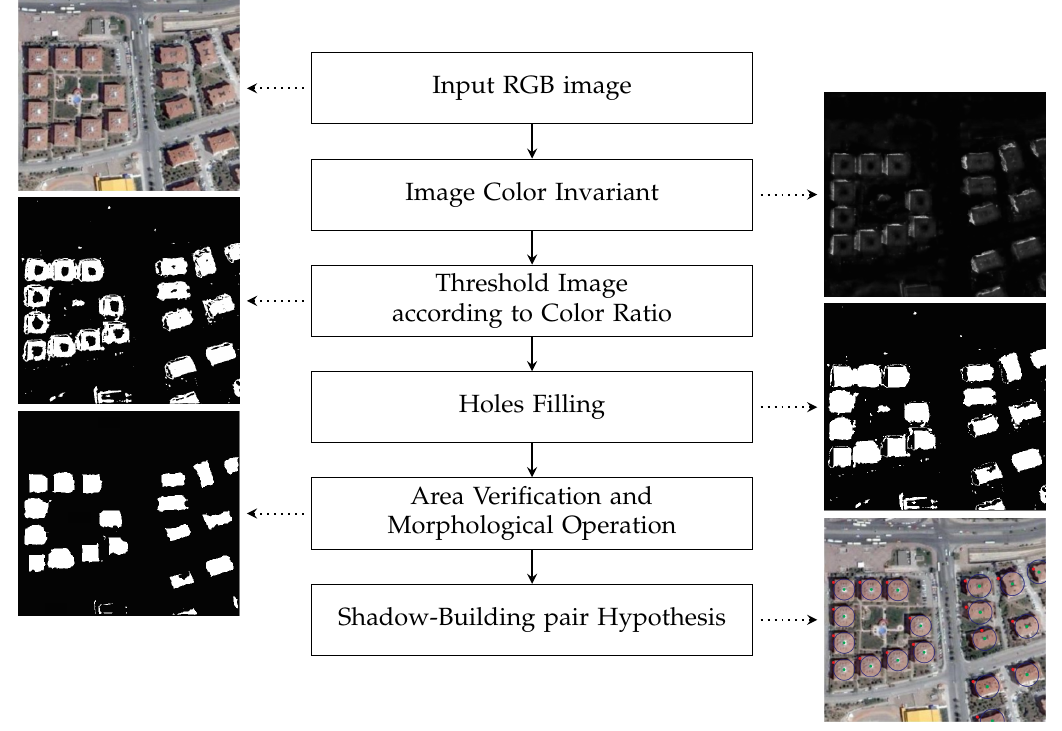
Figure 2. The tile building detection ( TBD )